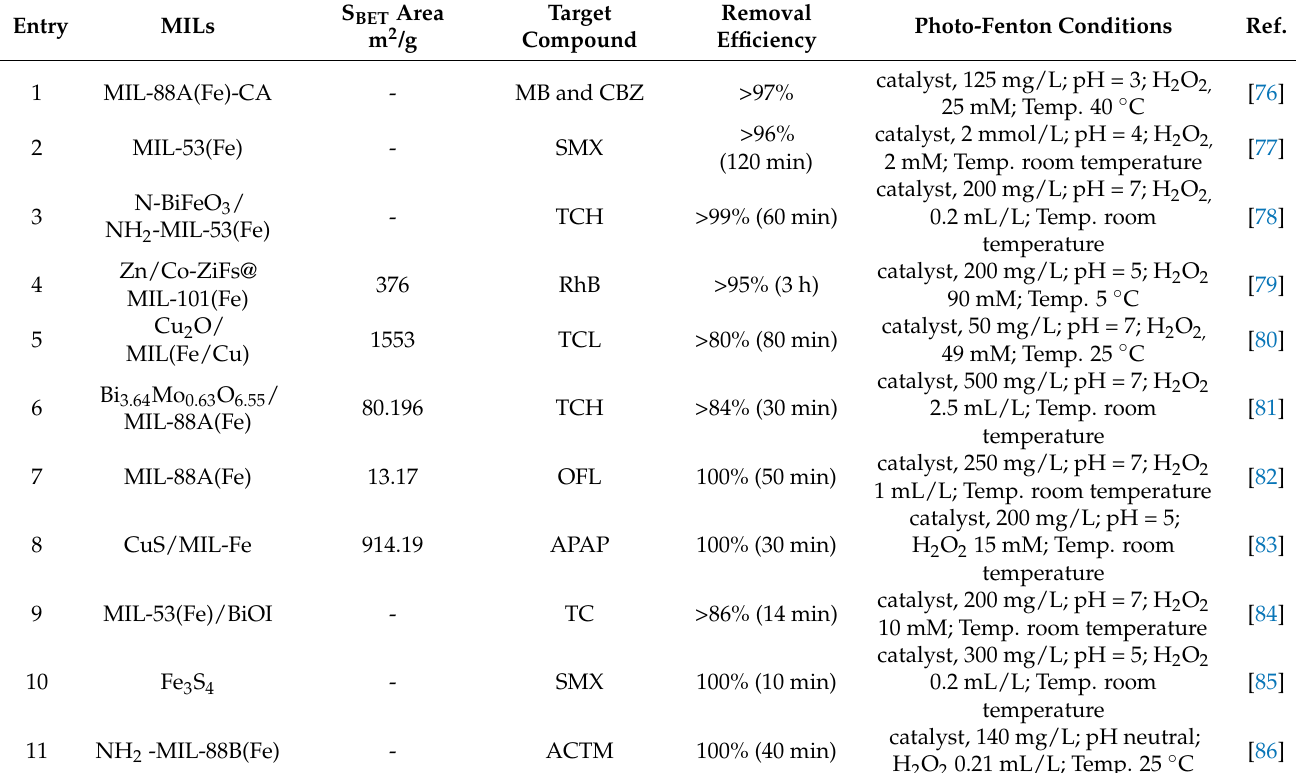
Table 3. Summary of MILs in photo-Fenton